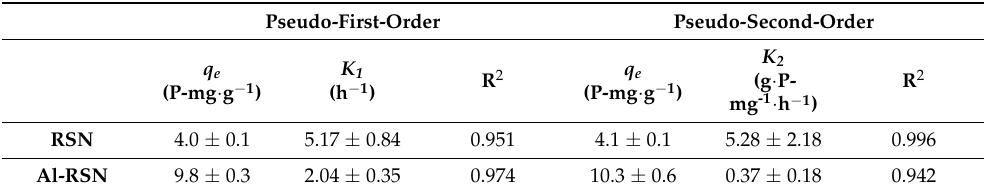
Table 6. Kinetic parameters for pseudo-first-order and pseudo-second-order models for RSNs and Al-RSNs.